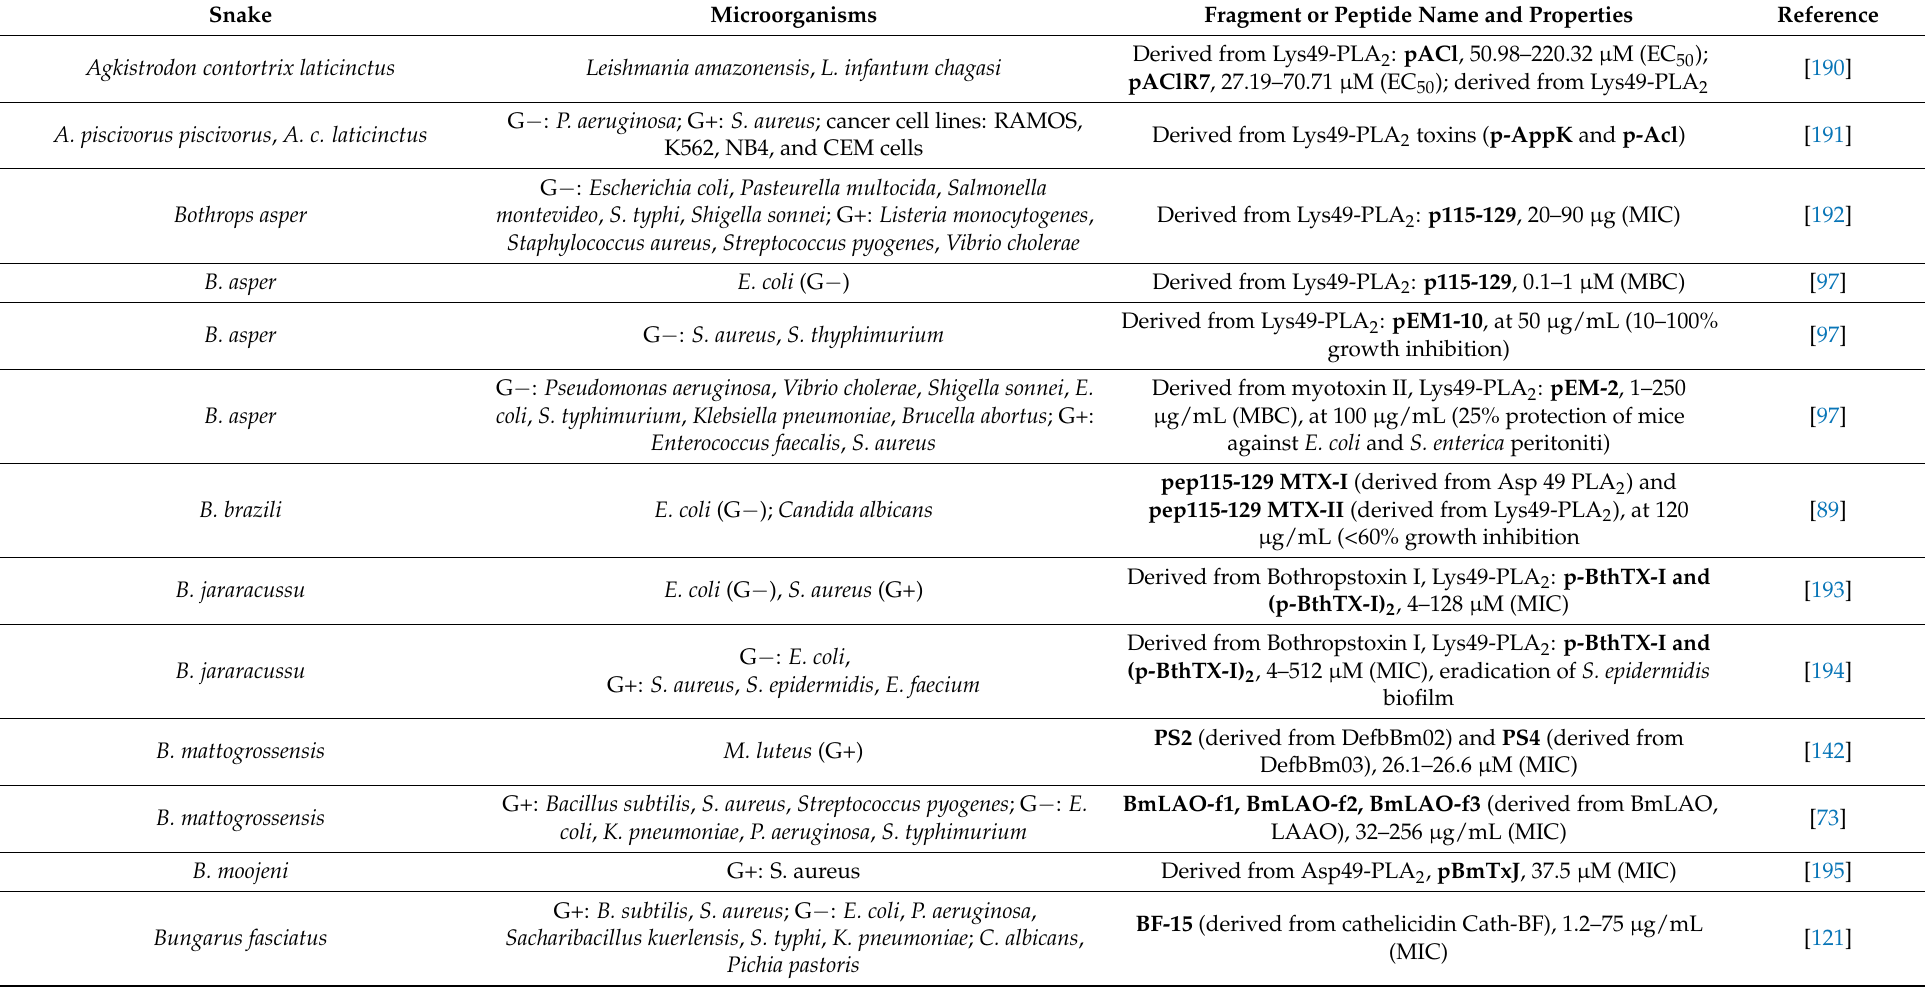
Table 6. Fragments derived from toxins and AMP and their antimicrobial action.